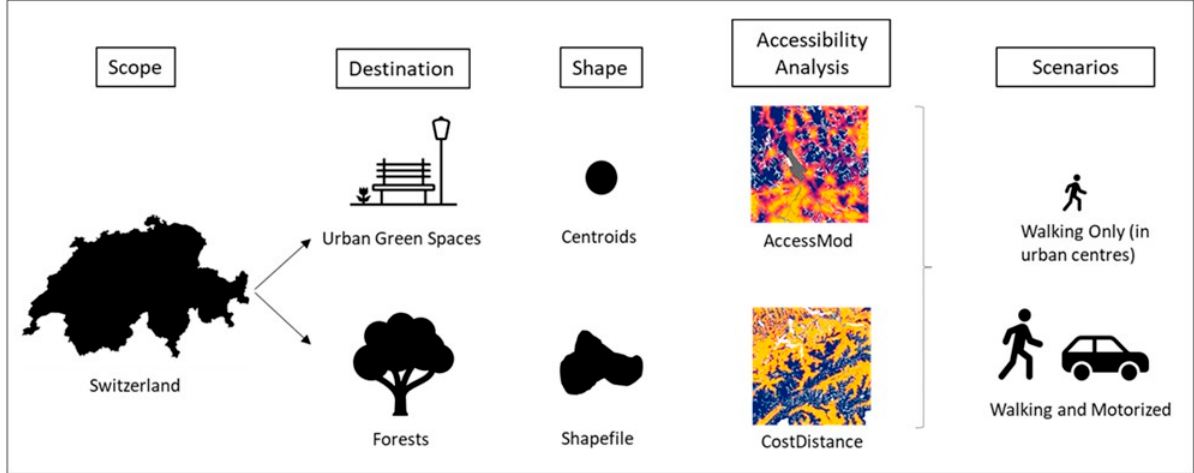
Figure 1. Summary of the methodology used.